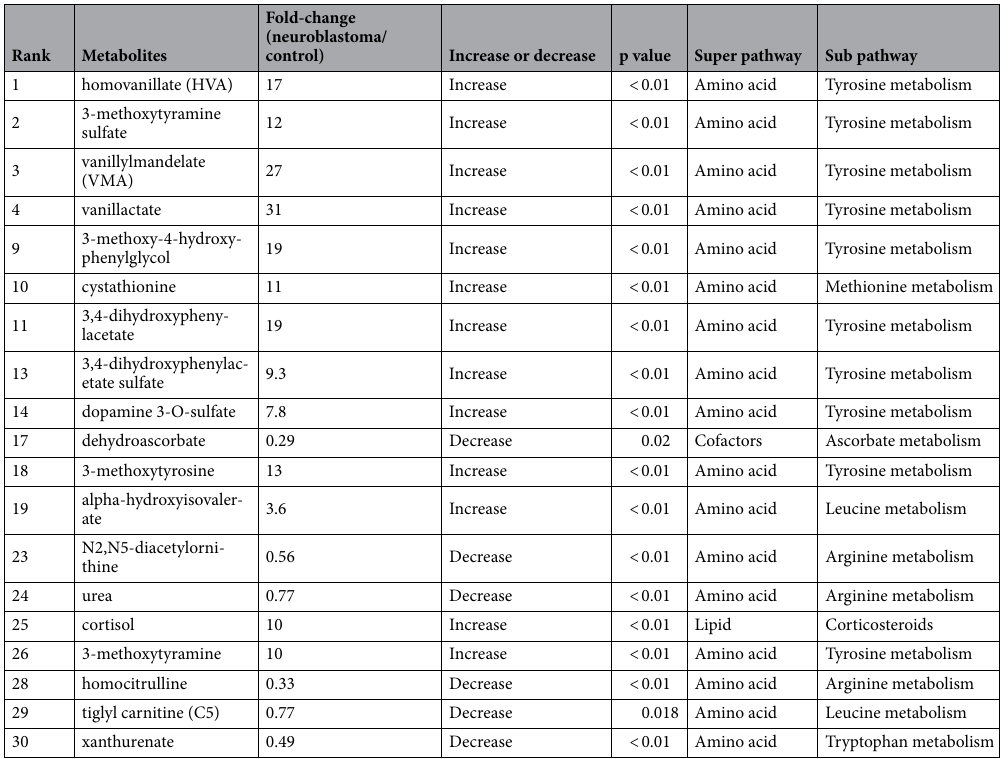
Table 2. Nineteen of the highest-ranking metabolites according to their contributions evaluated by the random forest